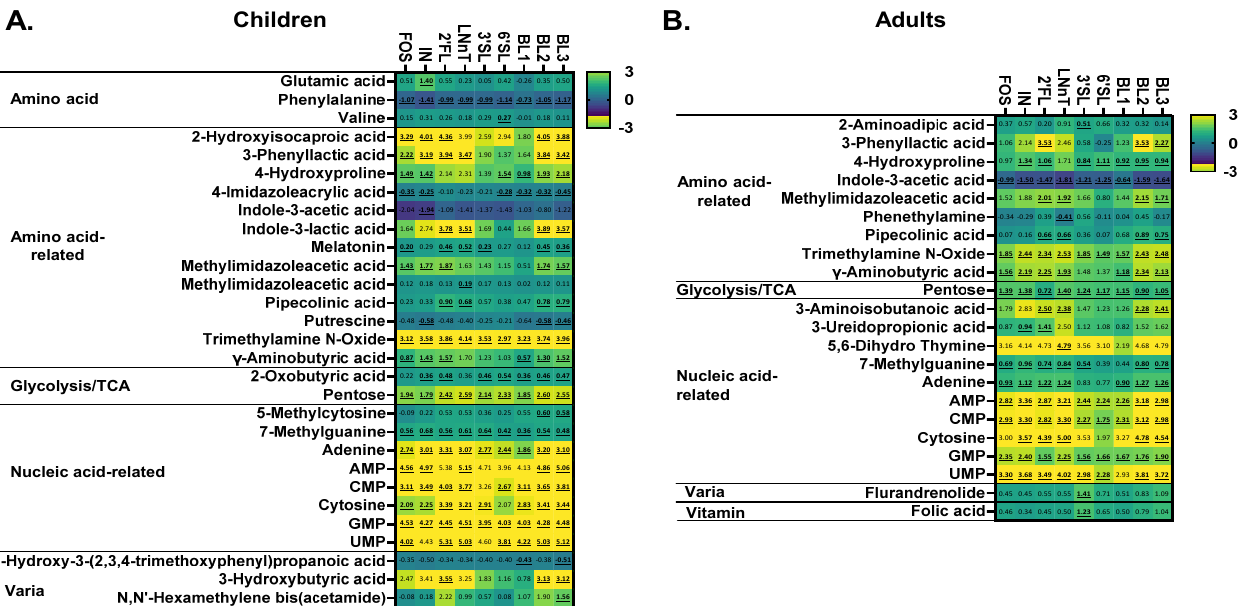
Figure 6. A spectrum of health-related metabolites increased (aromatic lactic acids, HICA and GABA). Impact of single HMOs (2 ′ FL, LNnT, 3 ′ SL, 6 ′ SL), mixtures thereof (BL1, BL2, BL3) and ref- erence prebiotics (FOS and IN) on gut metabolomics signatures in children ( A ) and adults ( B ) at 24 h upon initiation of treatment, as tested with the ex vivo SIFR ® technology. Heatmap representing average values of subsets of metabolites ( n = 6) that were signi fi cantly a ff ected by any of the treat- ments (FDR = 0.10), expressed as log2(ratio treatment vs. NSC). Signi fi cant di ff erences are indicated by bold and underlining. 2 ′ FL = 2 ′ Fucosyllactose; LNnT = Lacto-N-neotetraose; 3 ′ SL = 3 ′ Sialyllactose; 6 ′ SL = 6 ′ Sialyllactose; BL1/2/3 = HMO Blend 1/2/3; IN = inulin; FOS = fructooligosaccharides. For adults, milder e ff ects were observed for the 3-phenyllactic acid as compared to